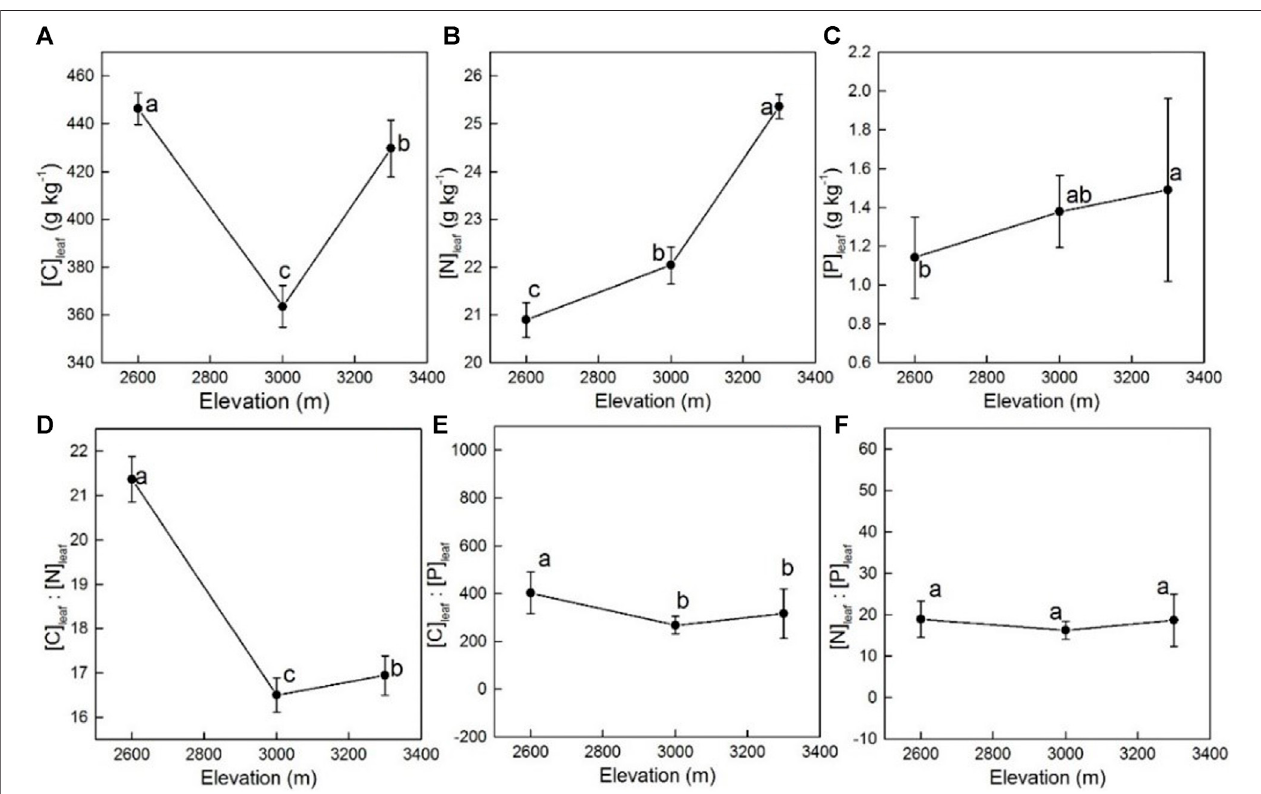
FIGURE 2 | L. virgaurea leaf carbon concentration (A) , leaf nitrogen concentration (B) , and leaf phosphorus concentration (C) and [C] leaf : [N] leaf (D) , [C] leaf : [P] leaf (E) , and [N] leaf : [P] leaf (F) at different elevations. [C] leaf , leaf carbon concentration; [N] leaf , leaf nitrogen concentration; [P] leaf , leaf phosphorus